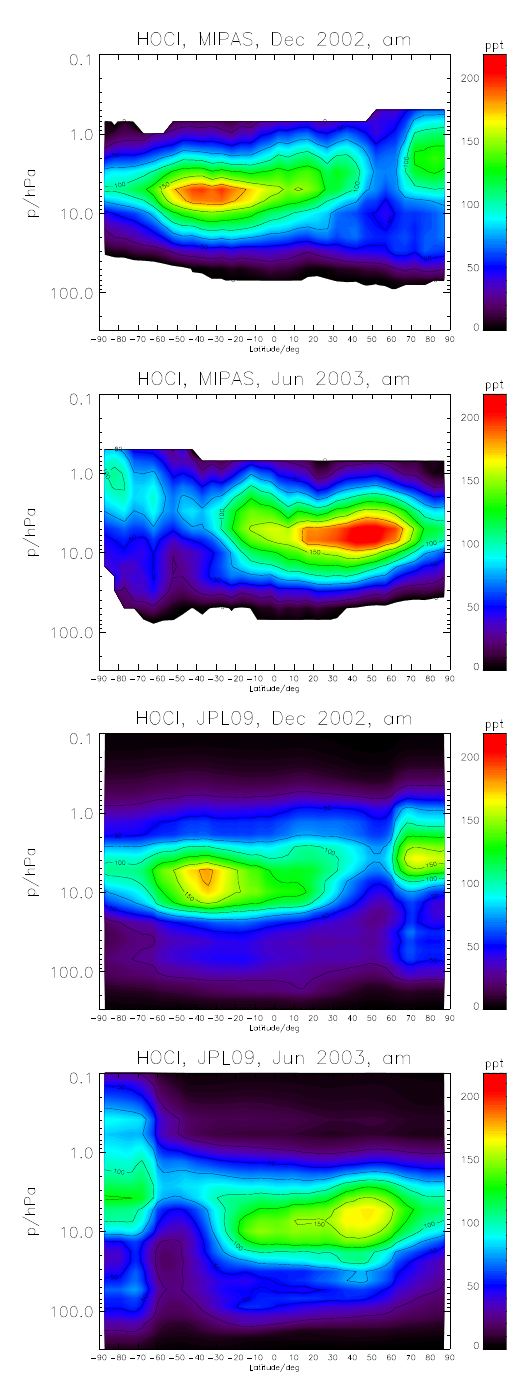
Fig. 2. Zonal mean HOCl distribution in December 2002 (top panel) and June 2003 (second panel). Measurements taken during the descending part of the orbit, i.e. morning measurements, are shown. The maximum mixing ratios are found in the summer hemisphere. White areas represent altitudes where MIPAS was not sensitive to HOCl. The lower panels represent the respective model calculations, after application of MIPAS averaging kernels.